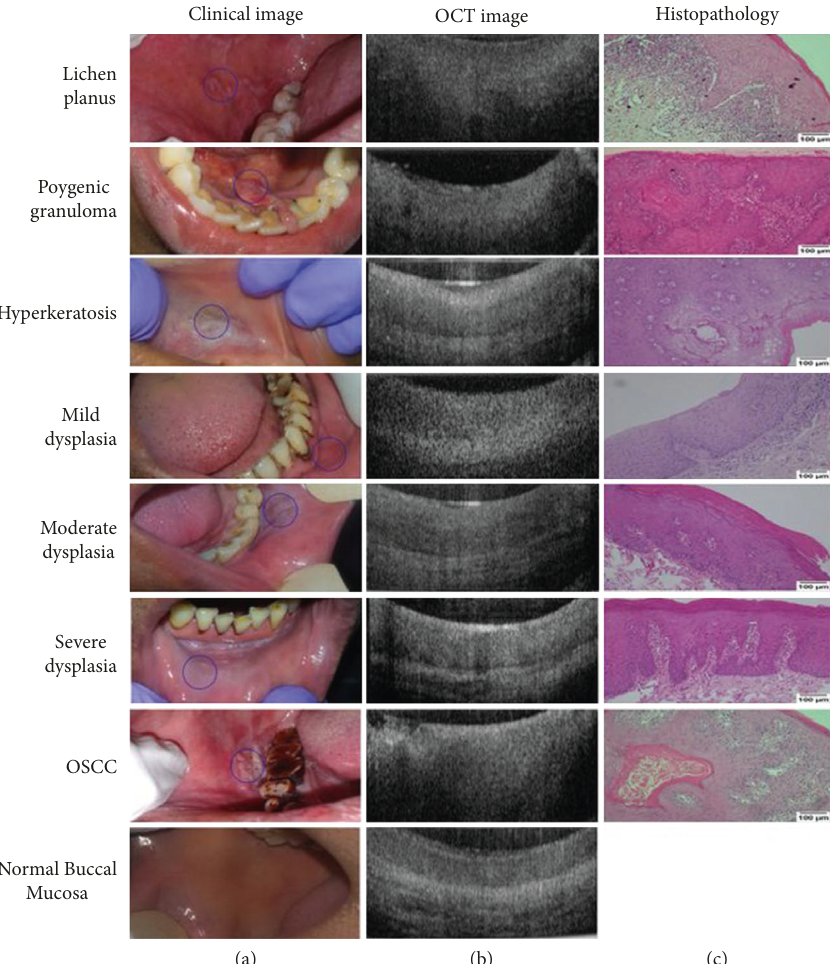
Figure 1: Clinical, OCT, and histological images. Clinical (a) and OCT (b) images were captured from all subjects, and biopsy samples were collected (wherever indicated) and assessed histopathologically (c). Histological images were taken at 100x resolution (scale bar � 100 μ m) using Nikon DSFi2 and NIS elements D4 20.0. The nondysplastic lesions shown were histologically diagnosed with lichen planus, pyogenic granuloma, and hyperkeratosis. Normal buccal mucosa images were taken from a healthy volunteer without any habit history. Repre- sentative images of all dysplastic grades and a buccal oral squamous cell carcinoma (OSCC) are also depicted (image courtesy of https://bit.